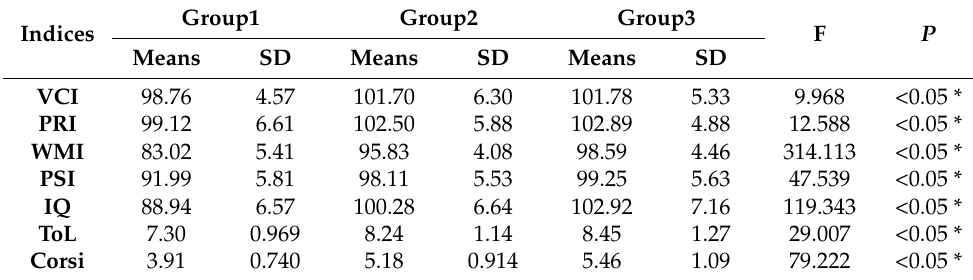
Table 2. Comparison of indices between group 1, group 2, and group 3. VCI: verbal